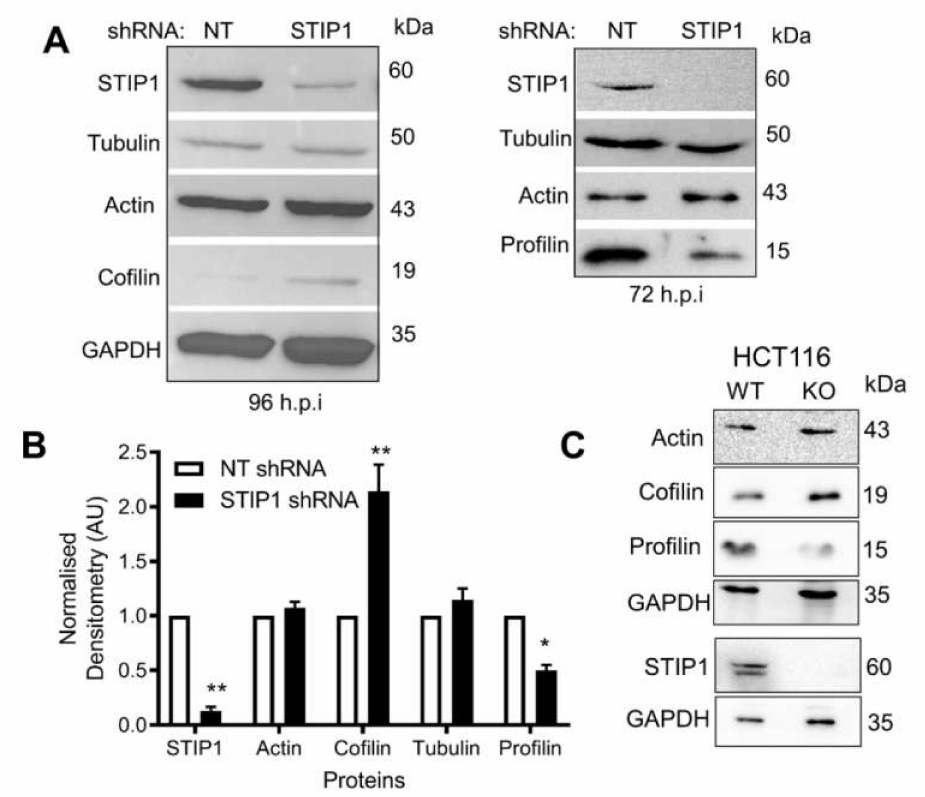
Figure 7. STIP1 depletion upregulated cofilin but downregulated profilin. ( A ) Knockdown of STIP1 in HEK293T cells using STIP1-specific RNA (STIP1 shRNA) and a non-targeting shRNA (NT shRNA)